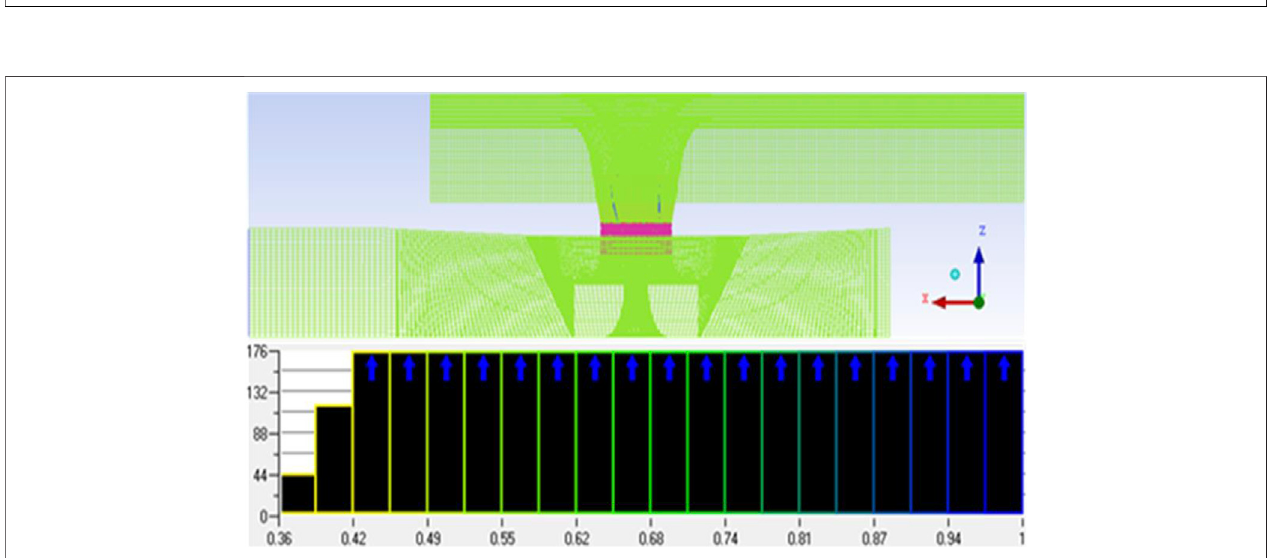
FIGURE 2 | Structural composition of vertical axial fl ow pump unit with tank channel.